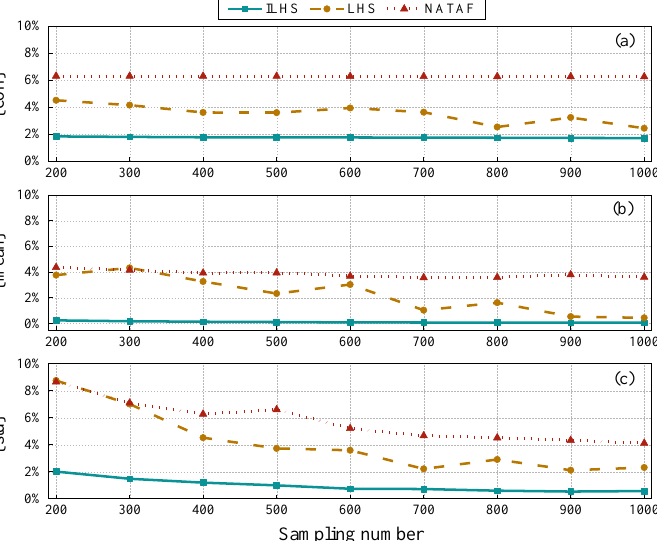
Figure 4. The variation curve of the error under different sampling scales: ( a ) the correlation coefficient error; ( b ) the mean error; and ( c ) the standard deviation error.